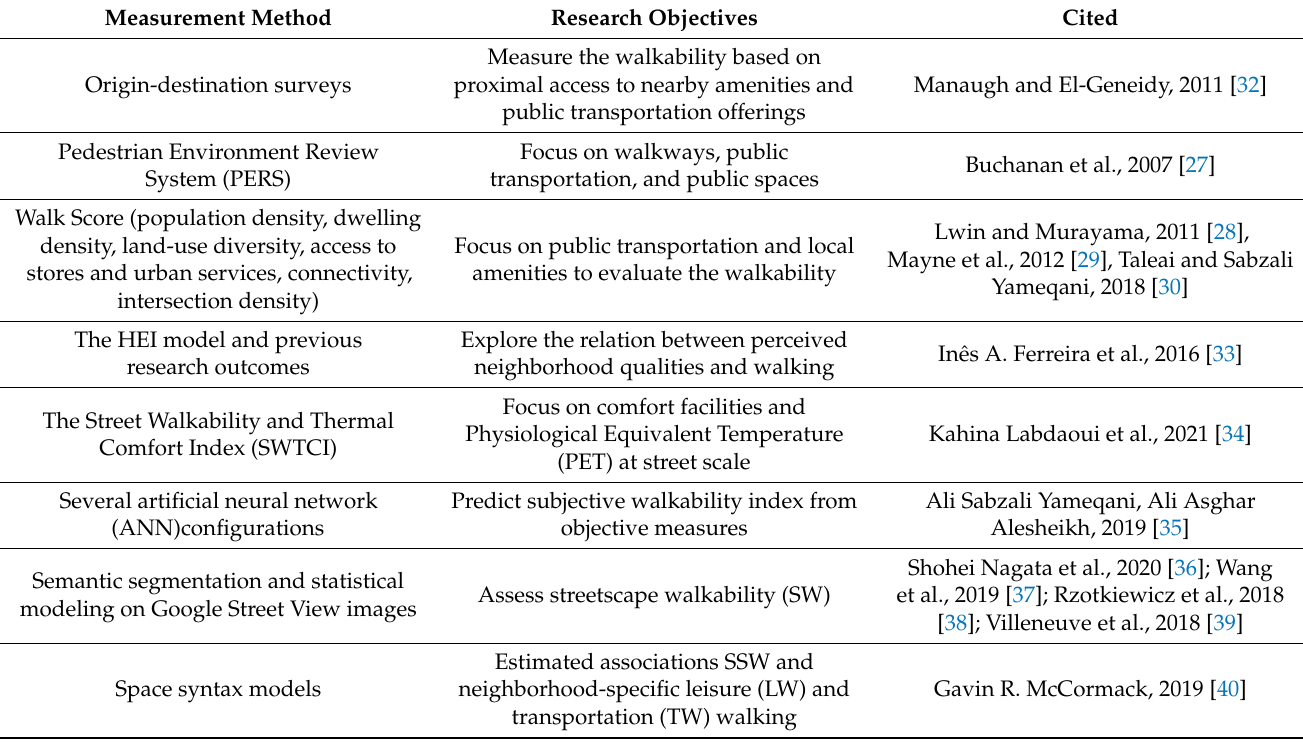
Table 1. Summary of quantitative methods for walking evaluation